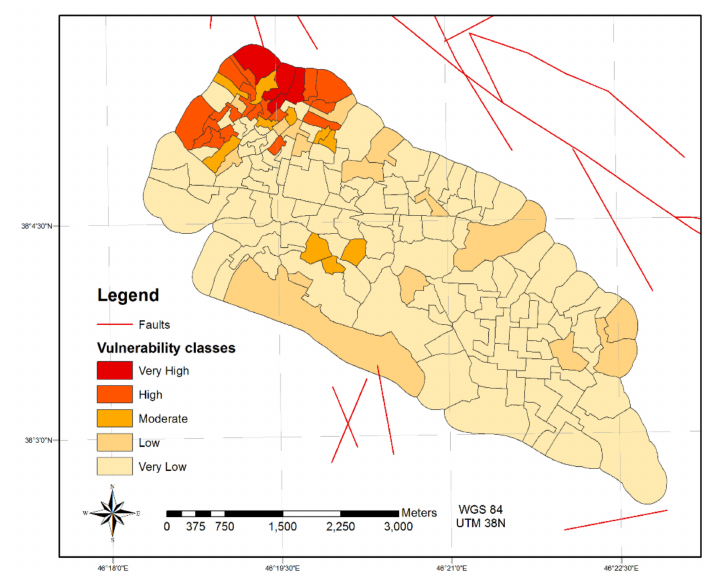
Figure 10. Map of seismic vulnerability of buildings.